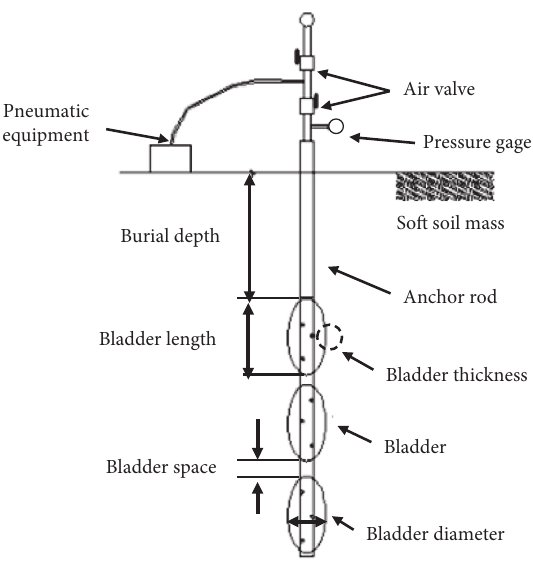
Figure 4: The schematic diagram of the multibladder-type inflatable